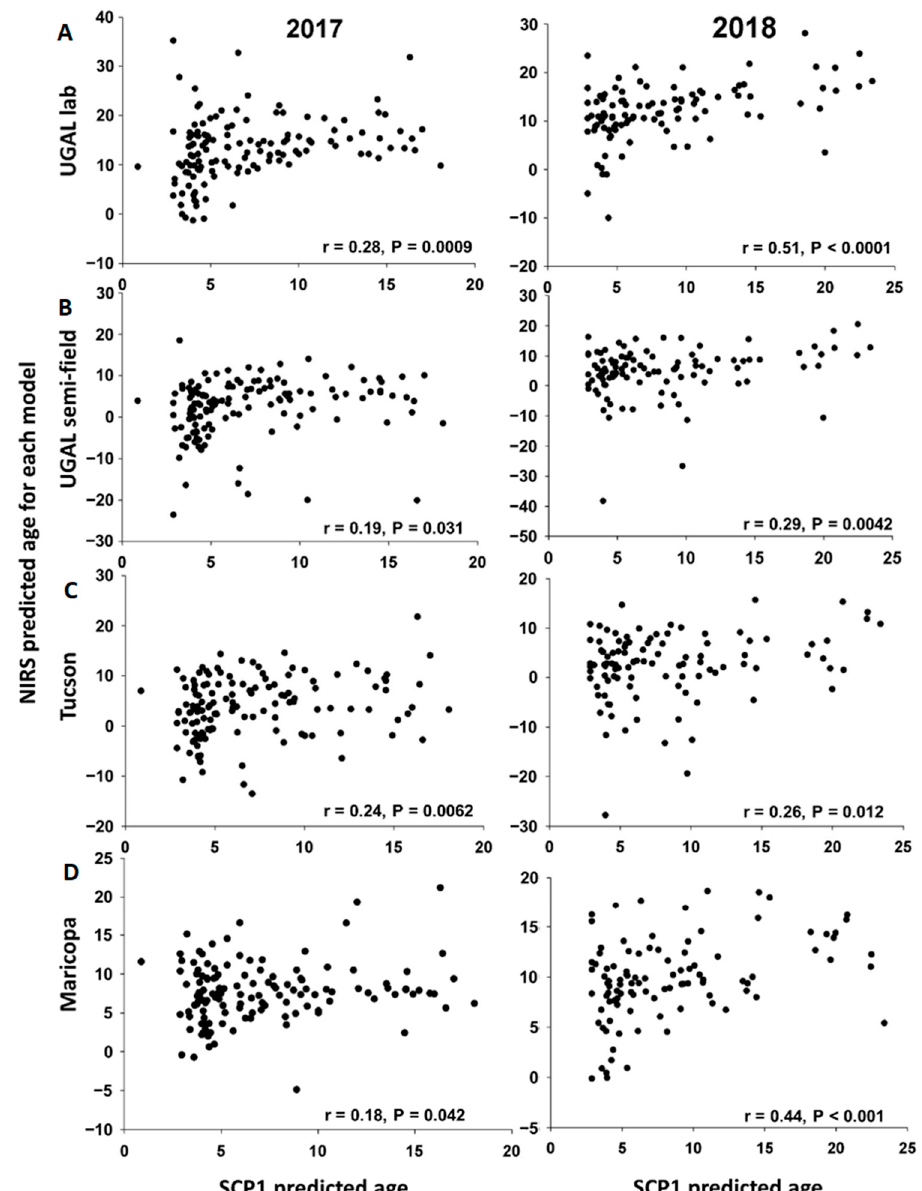
Figure 5. Scatterplots comparing the age of individual field-collected female Ae. aegypti predicted with SCP1 or the four NIRS models. For 2017 and 2018, the scatterplots show the relationship of individual age predictions based on SCP1 (X-axis) and each of the NIRS models (Y-axis). ( A ). UGAL lab, ( B ). UGAL semi-field, ( C ). Tucson and ( D ). Maricopa models. Table 2 . Linear associations between age predicted by SCP1 analyses and the four NIRS models in 2017 and 2018 . Data points with Studentized residuals > |2| were removed before estimating inter- cepts, slopes and their associated 95% confidence intervals (see Figure 5). N is the number of obser- vations used to fit simple linear regression models. 1 For each year, the slopes with different letter had non-overlapping 95% confidence intervals and are considered statistically different ( p < 0.05).